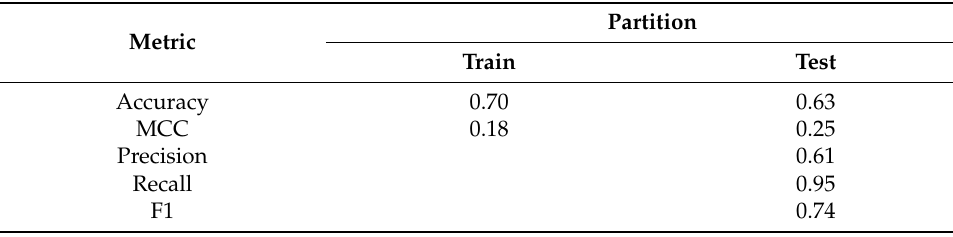
Table 4. Summary of the results by metrics and partition.